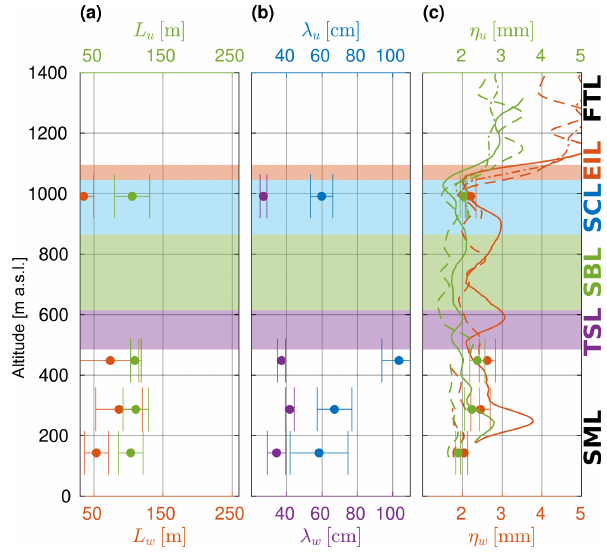
Figure 20. As in Fig. 19 but for the decoupled STBL (flight no. 14).